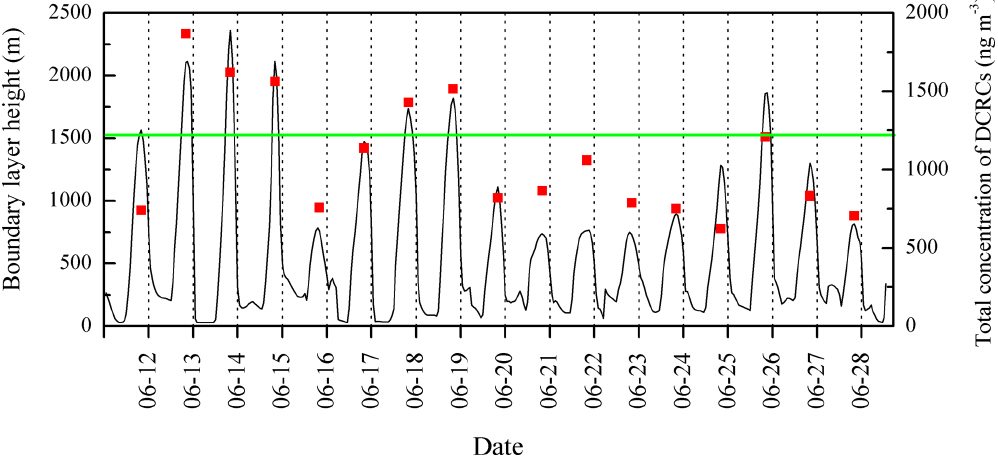
Figure 3. Boundary layer height in the Mt. Tai area during a selected sampling period modeled with the WRF model (red square: DCRC concentration; green line: height of sampling site). Table 2. DCRC concentrations reported in this study and literature data from the previous measurements at Mt. Tai in 2006 and other urban sites in the world (unit: ngm − 3